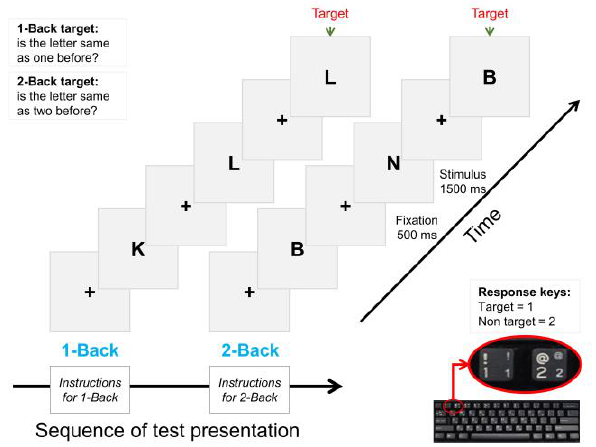
Figure 2. Structure of the N-back task.